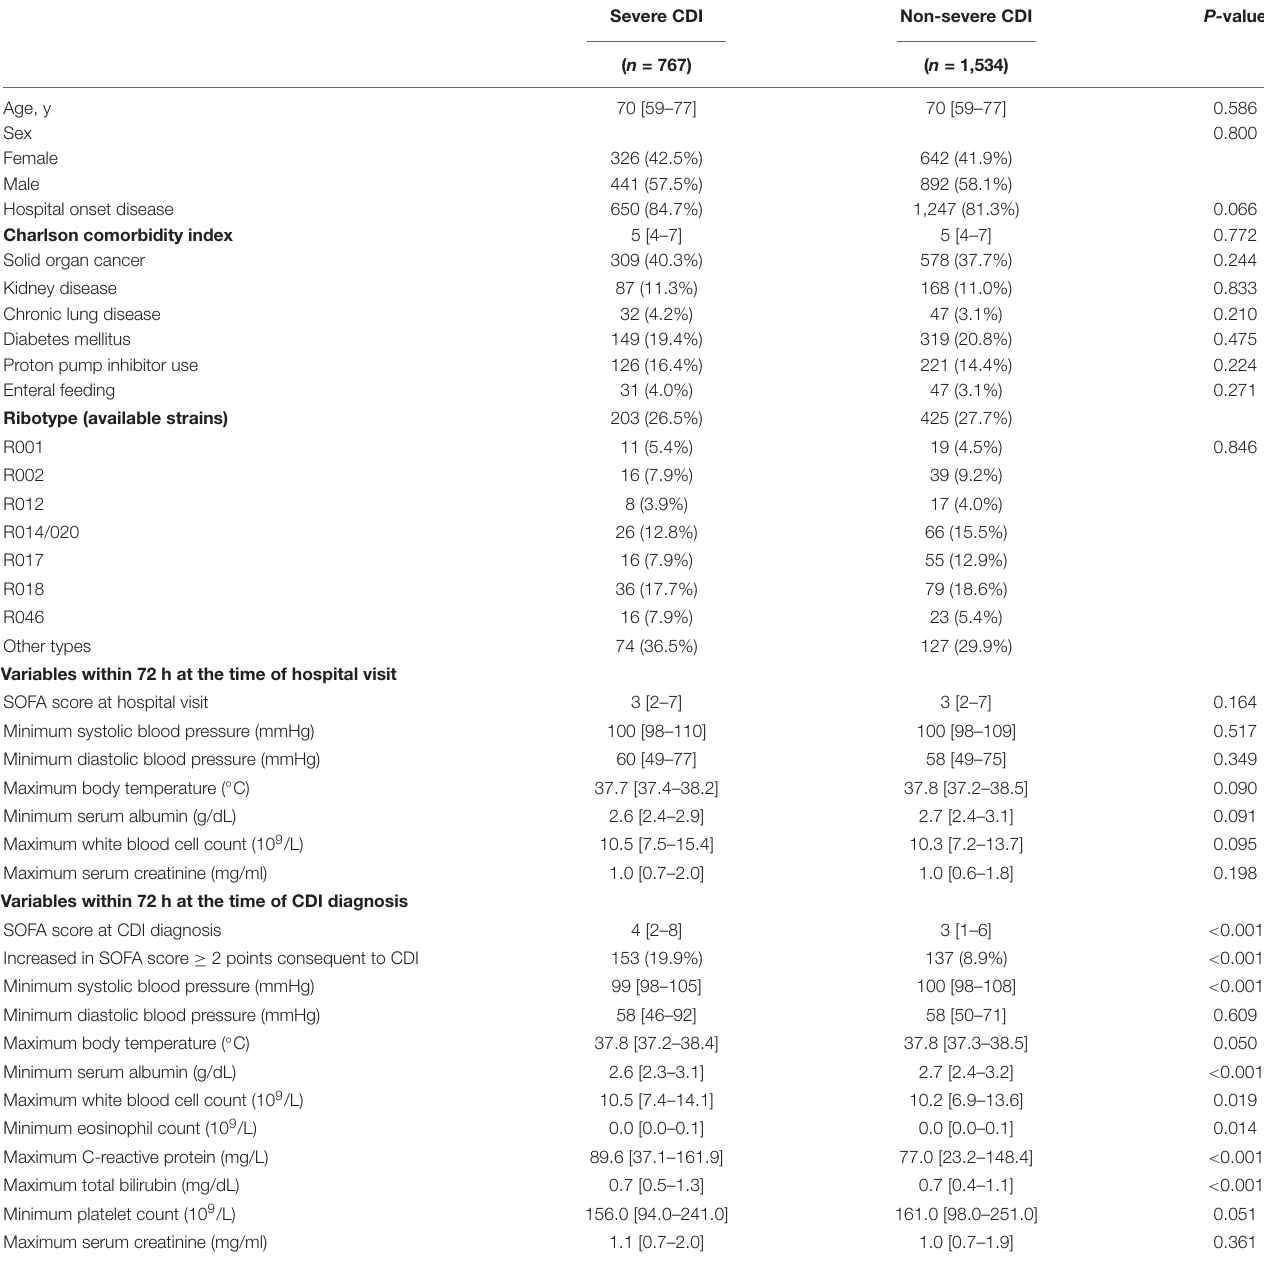
TABLE 2 | Baseline characteristics of patients with CDI, after propensity-score